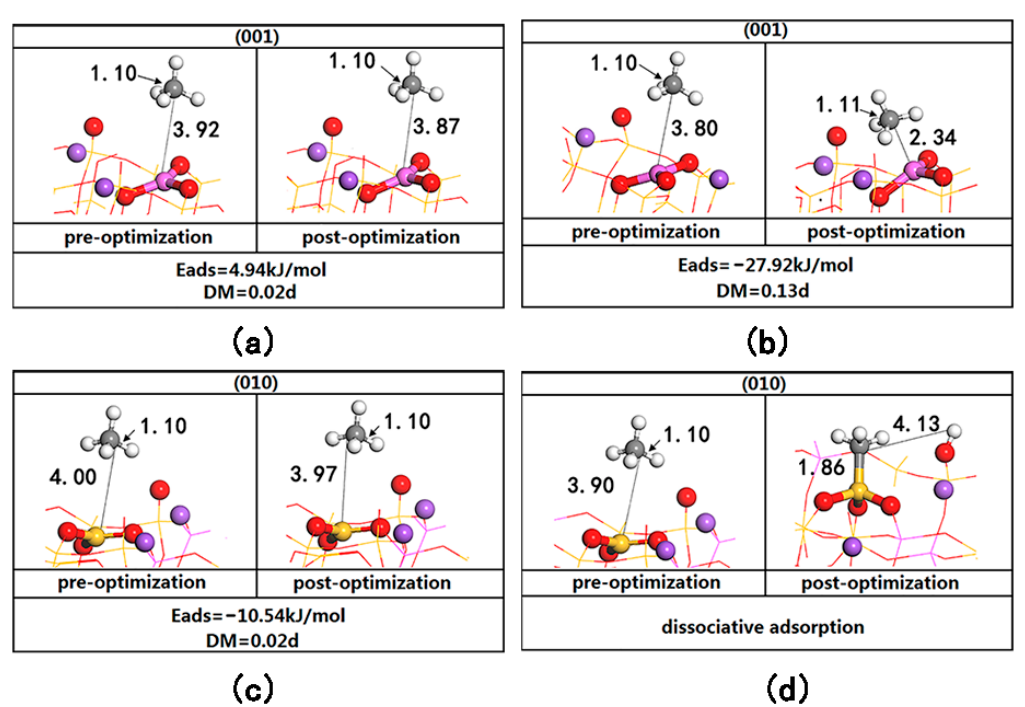
Figure 3. Adsorption configuration of CH 4 before and after (001) and (010) surface optimization. ( a ) is the adsorption configuration before and after optimization when (001) surface d C-Al = 3.92 Å. ( b ) is the adsorption configuration before and after optimization when (001) surface d C-Al = 3.80 Å. ( c ) is the adsorption configuration before and after optimization when (010) surface d C-Si = 4.00 Å. ( d ) is the adsorption configuration before and after optimization when (010) surface d C-Si = 3.90 Å.